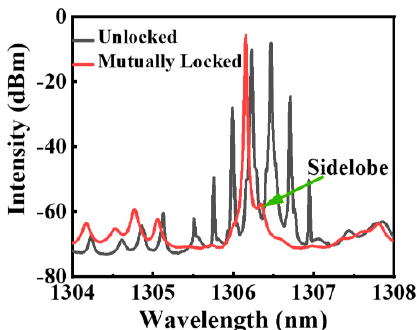
Figure 5. The optical spectra of the IMC laser with I DFB1 = 131 mA (red) under the MIL state and I DFB1 = 142 mA (dark) under the unlocked state. Here, I DFB2 and I SOA were fixed at 40 mA and 5 mA, respectively.